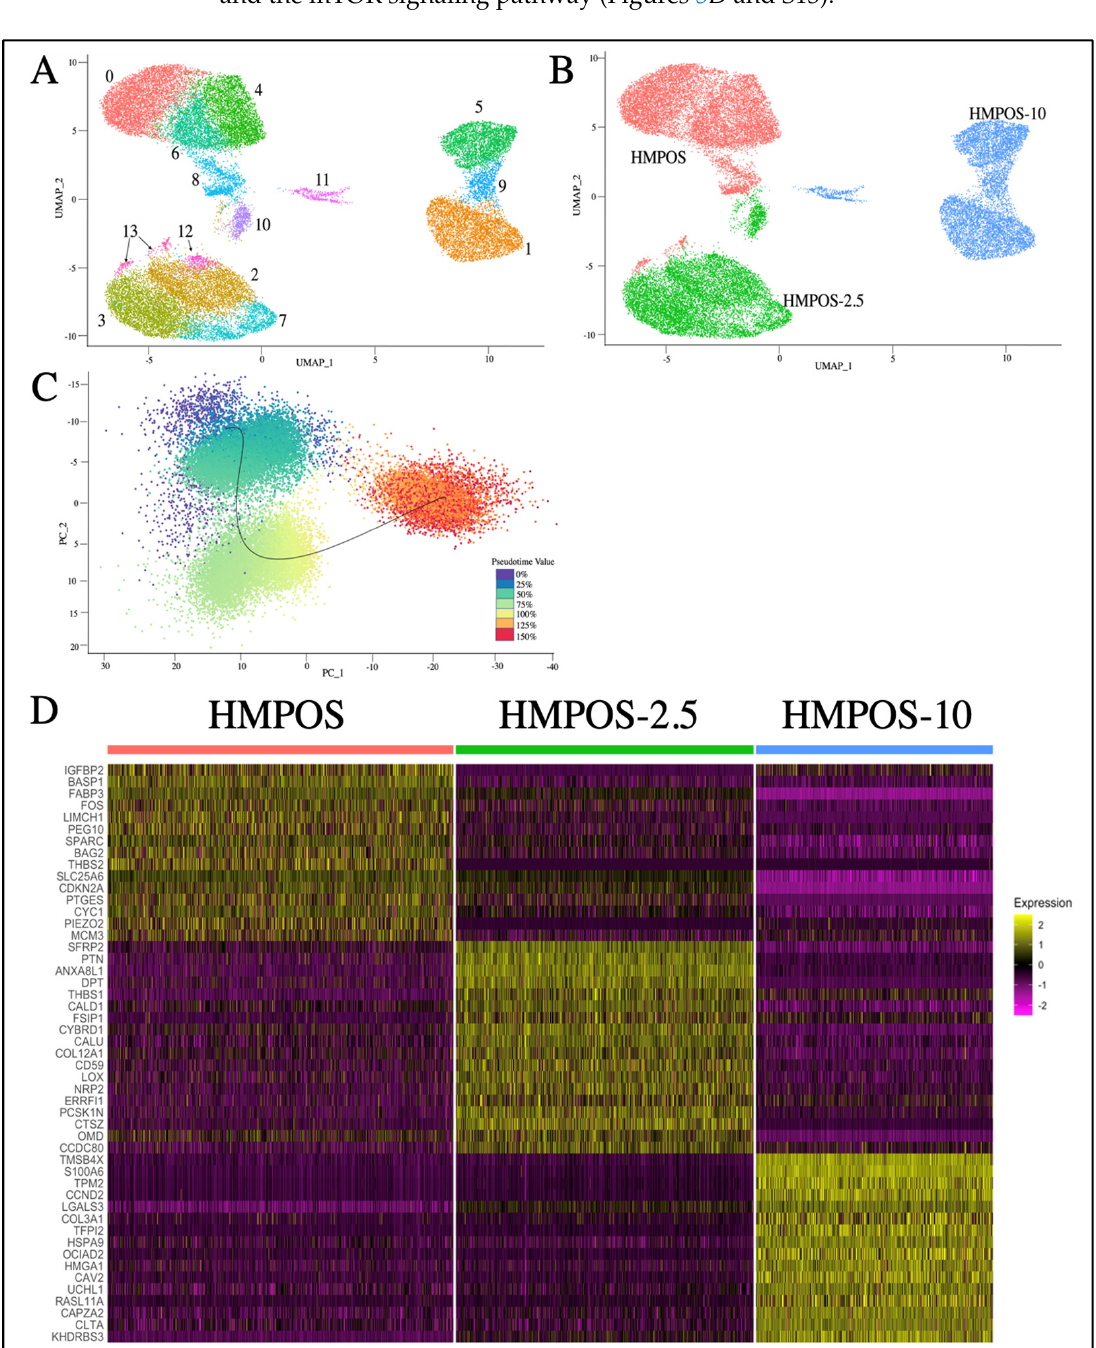
Figure 3. ( A ) UMAP plot of HMPOS, HMPOS 2.5, and HMPOS 10 showing the cell lines. ( B ) UMAP of the Seurat clusters in which HMPOS makes up clusters 0, 4, 6, 8, and 13, while HMPOS-2.5 forms clusters 2, 3, 7, 10, and 12, and clusters 1, 5, 9, and 11 are made up of HMPOS-10 cells. ( C ) PCA jitter plot highlighting the different cell stages and inferred trajectory. ( D ) Heatmap showing the highest differentially expressed genes for each cell line. This list was put together by selecting the top 20 genes for each cell line based on avg_log2FC, which is the log fold-change in the difference in expression between groups where positive values indicate that the expression of a gene is greater in the first group. Eight genes with no gene symbol listed were dropped.